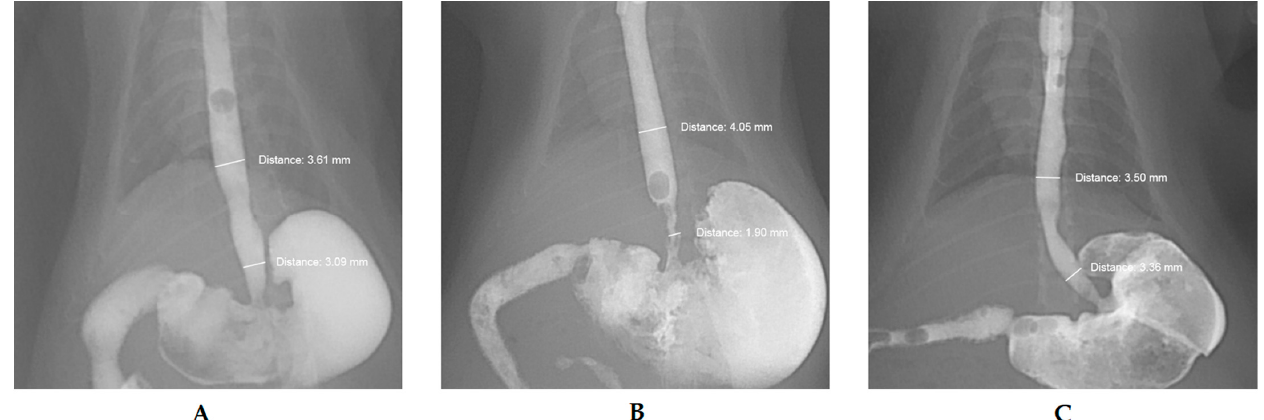
Figure 1. Fluoroscopic esophagogram with contrast media at 3 weeks after surgery. The stenosis ratio was determined by comparing the axial diameter in both the upper undamaged area and the lower stenosis area. Healthy rat; rat with corrosive burn but without TGF- β 1 inhibitor treatment (control); rat with corrosive burn and with TGF- β 1 inhibitor treatment (treatment) (( A – C ), respectively). The figure demonstrates significantly less esophageal stenosis in the treatment group compared with the control group ( p = 0.001).